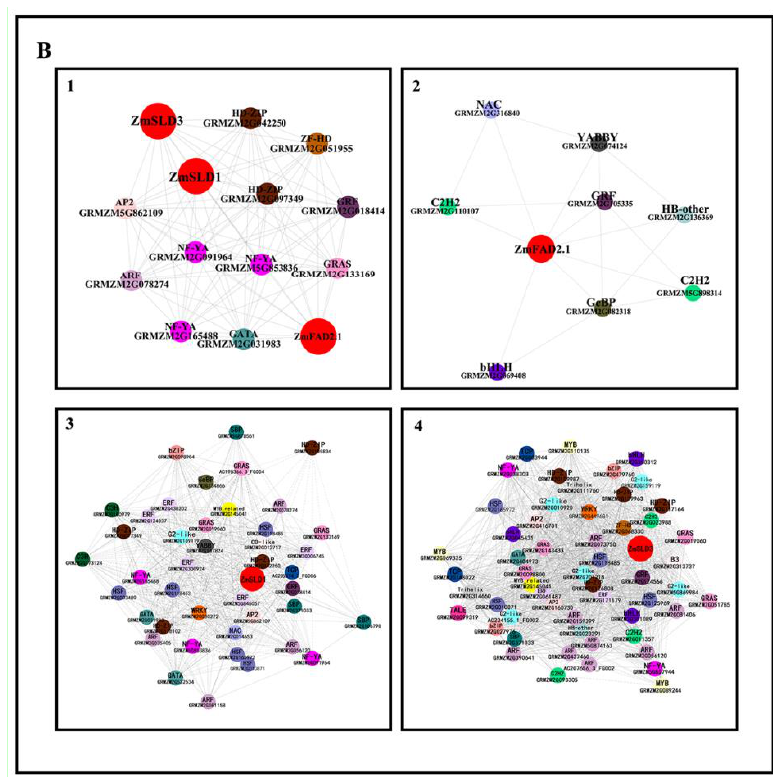
Figure 7. Co-expression network of transcription factors and maize FADs . ( A ) Under cold stress; ( B ) Under heat stress. The co-expression relationship was established when the Pearson correlation was higher than 0.97, and the co-expression network was built using the Perl script with a default value of 0.6. Different colored circles represent different transcription factors.